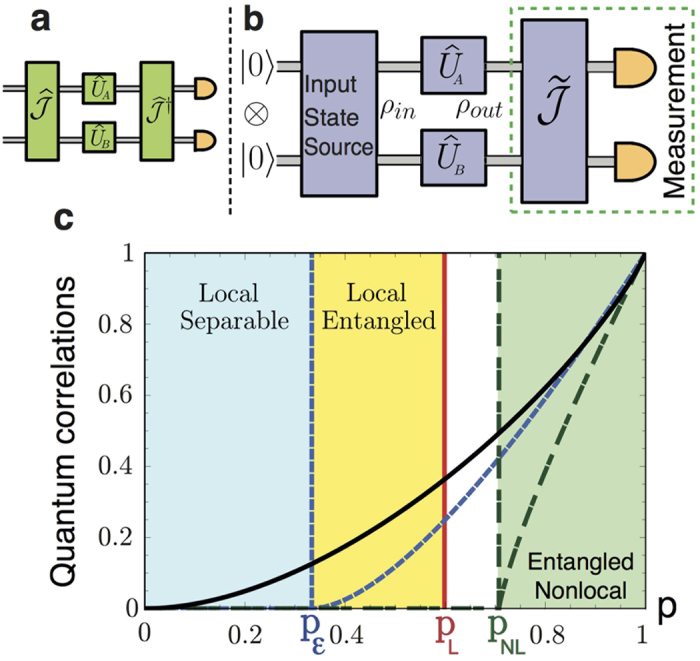
Quantum Prisoners’ Dilemma setup and classification of input correlations.(a) Eisert et al. two players game protocol7, (b) our setup uses a source of input  (e.g., Werner-like) states, one qubit gates to represent the players’ moves, and the measuring process (dashed rectangle). The measurement is taken as the projection onto the basis generated by  in the usual 4-dimensional basis, (c) quantum correlations of input ρW-l(p) states: discord  (solid-black), entanglement of formation  (dashed-blue), and CHSH-nonlocality (doubly-dashed green). justification = justified.